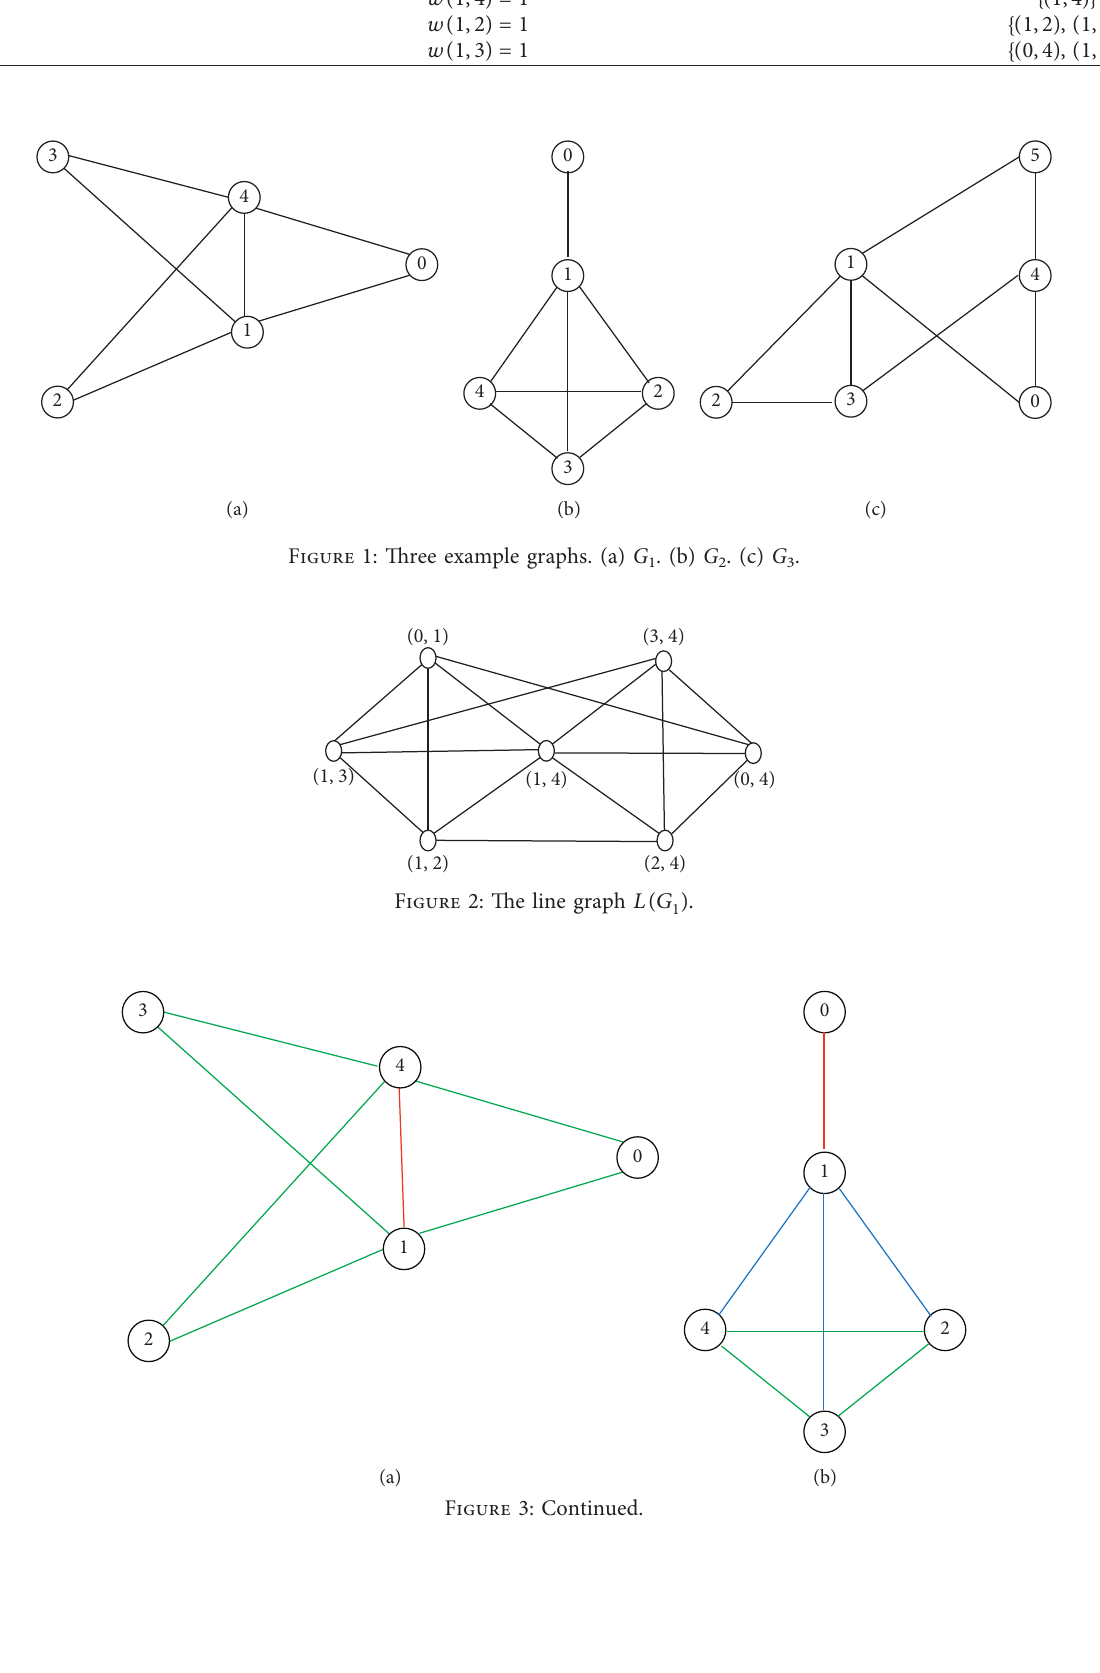
Table 1: Optimal weight assignments for minimizing the Wiener index with edge dominating sets of graphs in Figure 1. Graph